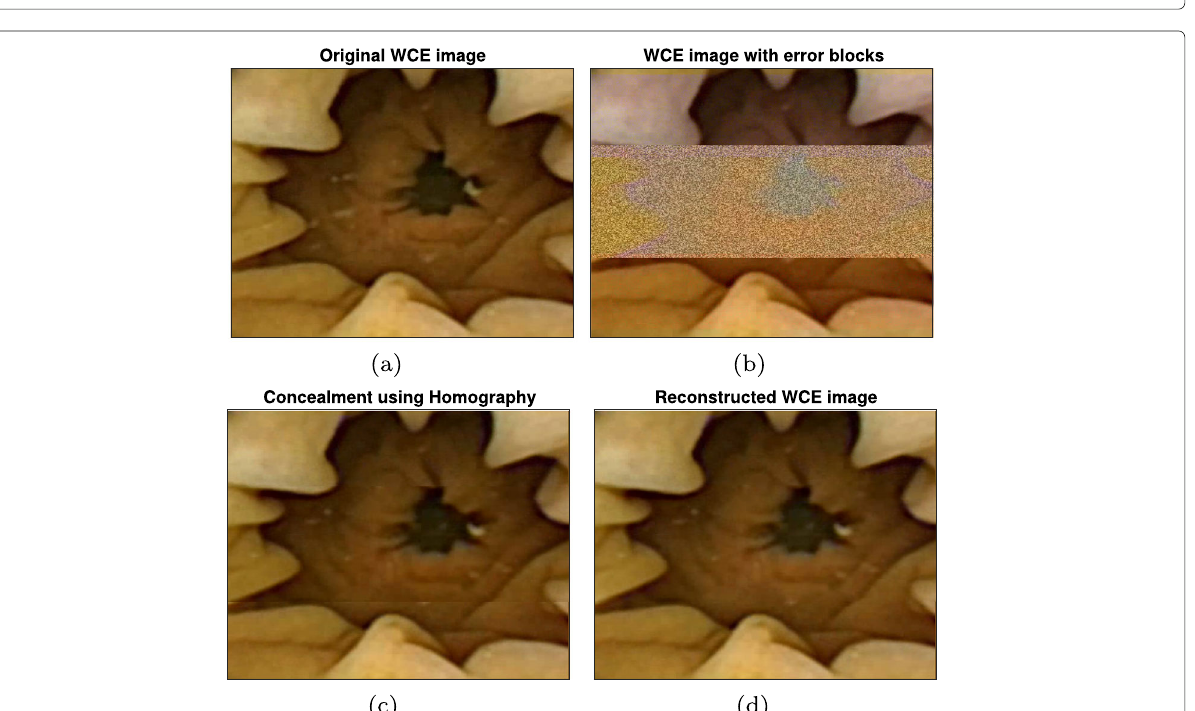
Fig. 7 Correction of error blocks. a Original WCE image. b WCE image with error blocks in Y , U , and V channels. SSIM = 0.55 c Corrected image using H . SSIM = 0.91 d Corrected image using H and poisson editing. SSIM =